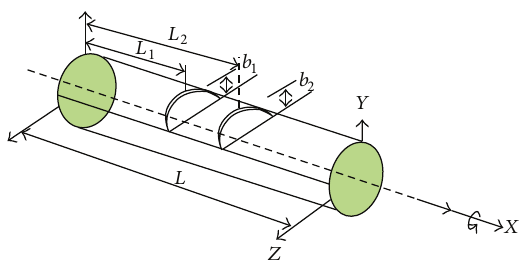
Figure 2: Shaft with multiple